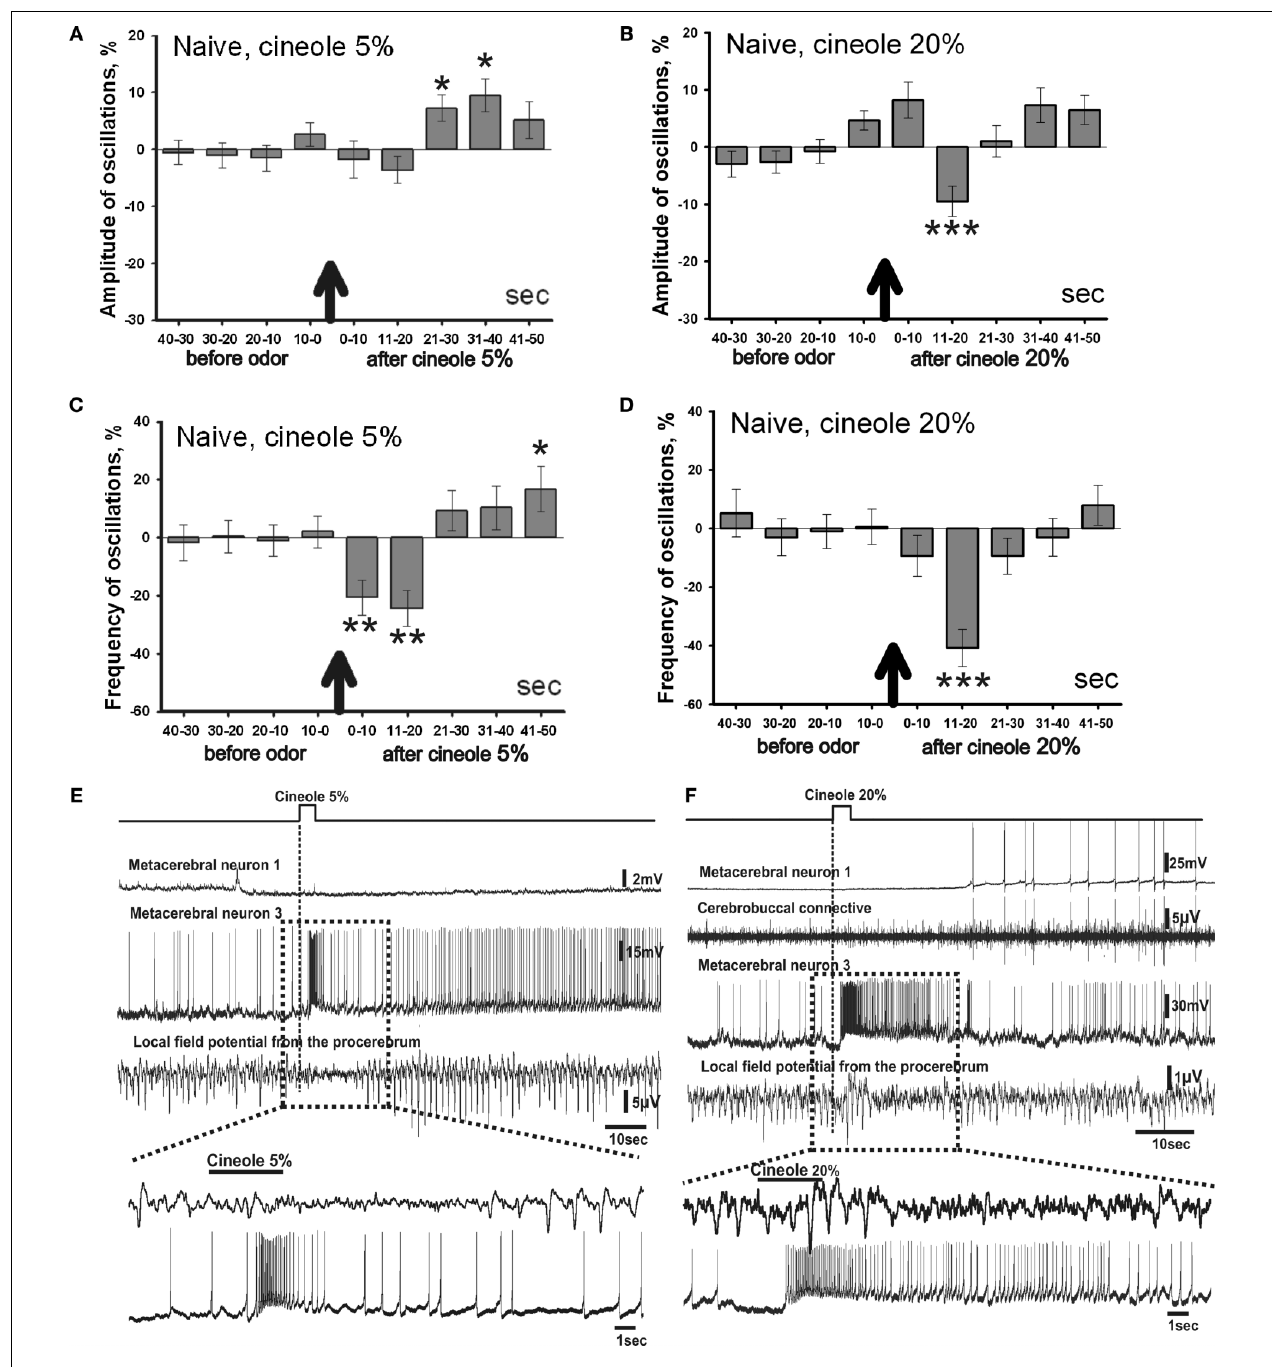
FIGURE 4 | Averaged changes of the oscillatory rhythm recorded in vitro in the procerebrum of naïve snails in response to odor application. (A) Changes in the amplitude of the procerebral oscillations in response to the cineole application in 5% ( n = 5) and (B) 20% ( n = 6) concentrations. (C) Changes in the frequency of the procerebral oscillations in response to cineole application in 5% ( n = 5) and (D) 20% ( n = 6) concentrations. Vertical bars indicate the standard error of the mean. Statistical signifi cance here and on further fi gures was calculated in relation to the mean of the frequency or amplitude for 20 s before odor application taken as 100%. * p < 0.05, ** p < 0.01, *** p < 0.001, ANOVA, Dunn’s method. (E,F) The response of the procerebrum, MtC3, MtC1